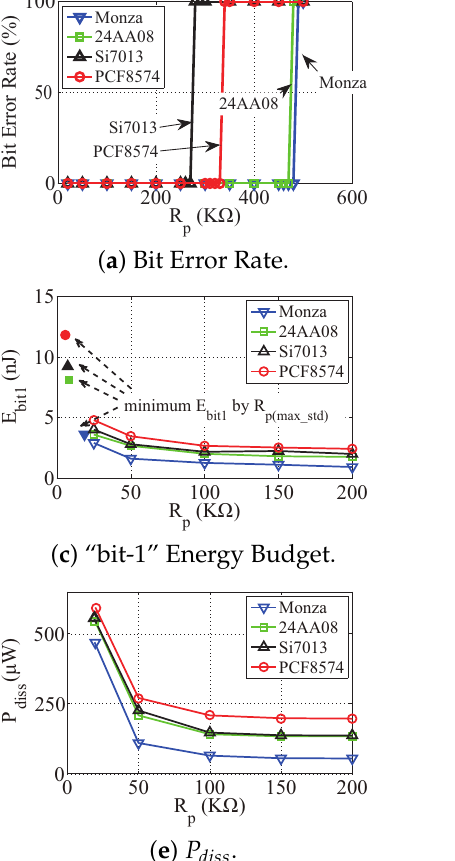
Figure 11. Experiment results of Turbo . The BER over different R p is shown in ( a ). We use “100% BER” to illustrate the case in which there are no bits (no matter the bits are correct or not) that can be transmitted via bus lines since both the SDA and SCL lines fail to work. The bit energy budget over different R p is shown in ( b , c ). We also mark the bit energy budget associated with the maximum standard resistance R p ( max _ std ) as a comparison in ( b , c ). As the sink rate of energy budgets becomes slow along with R p , we recommend an empirical value R p = 50 K Ω as a general resistance selection for low power purpose. The maximum bit rates achieved with different R p values are shown in ( d ), and the overall power dissipation of I 2 C bus over different R p is shown in ( e